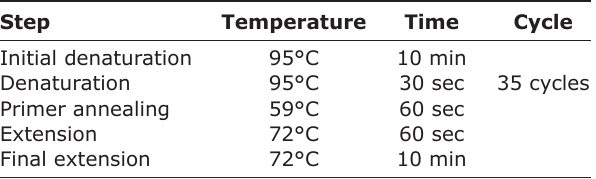
Table-2: Cycling conditions for the PCR